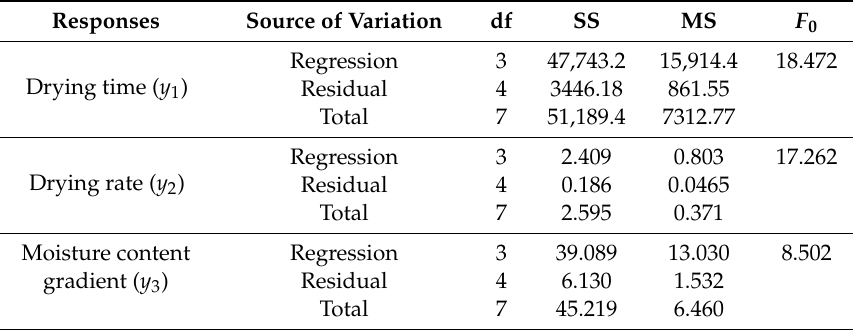
Table 5. Results from analysis of variance (ANOVA) for the RSM